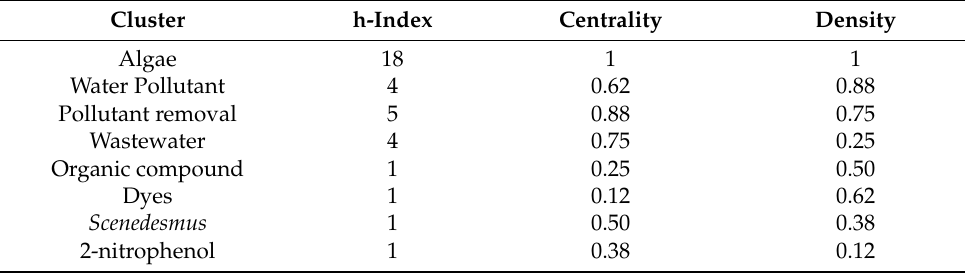
Figure 9. Strategic diagram of the third period (2011–2015). Table 3. The measures for themes of the third period